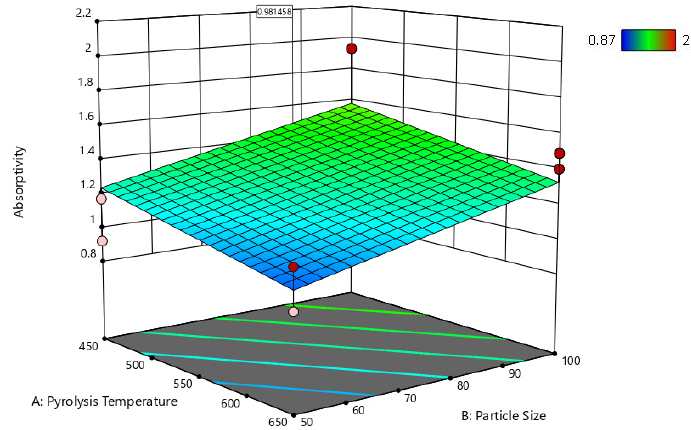
Figure 15. Surface response of the water absorptivity of the hemp biocarbon composites as a function of pyrolysis temperature and the particle size when the particle loading is 20%.